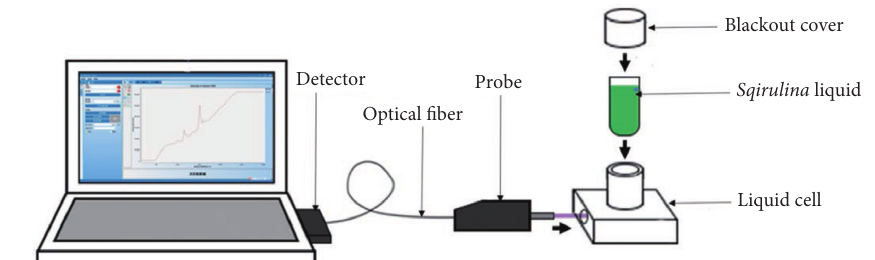
Figure 3: Detection process of the portable Raman spectrometer.